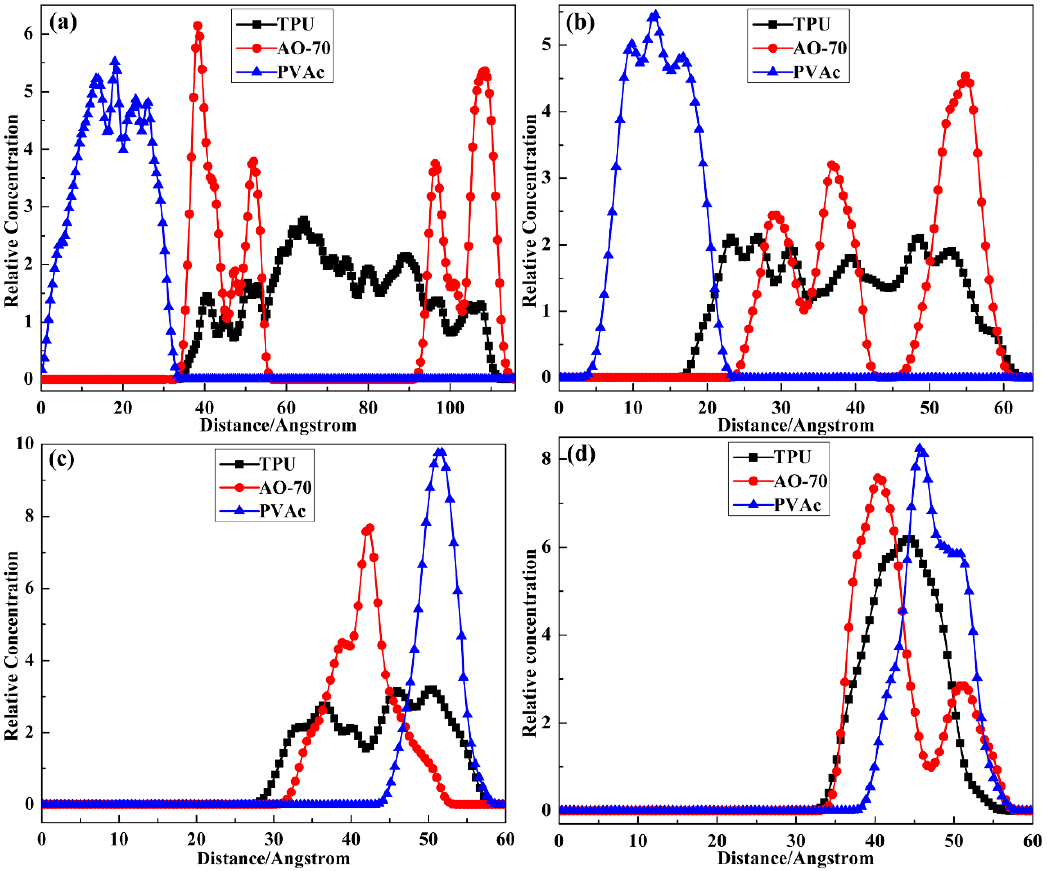
Figure 4. Relative concentration of chains along the c axis of the layer cells: ( a ) TP2; ( b ) TP8; ( c ) TP16 and ( d ) TP32.